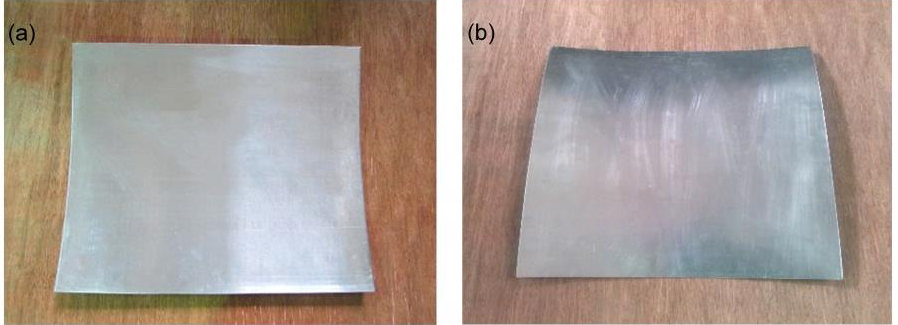
Figure 12. Formed parts by the continuous roll forming (CRF) equipment: ( a ) convex surface; ( b ) saddle surface.